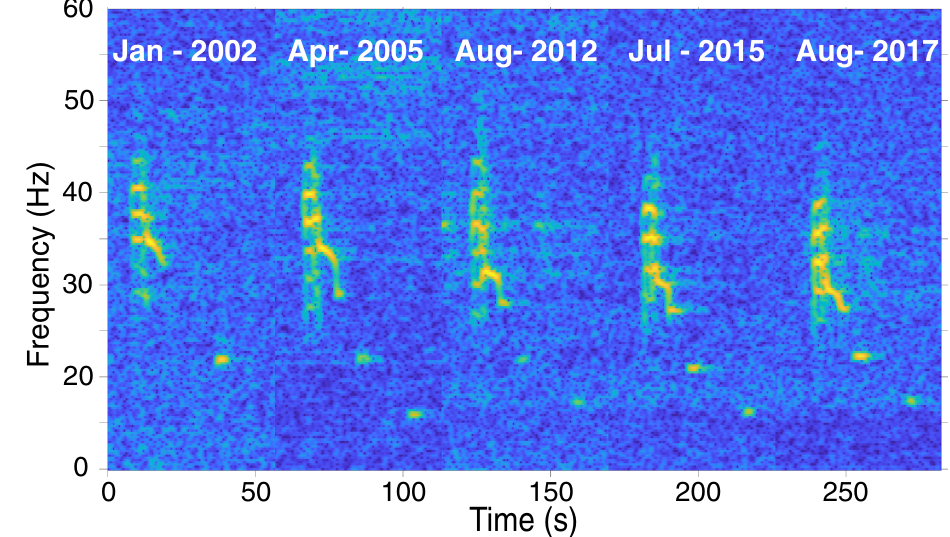
Figure 4. The decline in frequency of the Chagos song from 2002 to 2017: spectrogram representation of five songs recorded at Diego Garcia in years 2002, 2005, 2012, 2015 and 2017. Spectrogram parameters: Hamming window, 1024-point FFT length, 90%